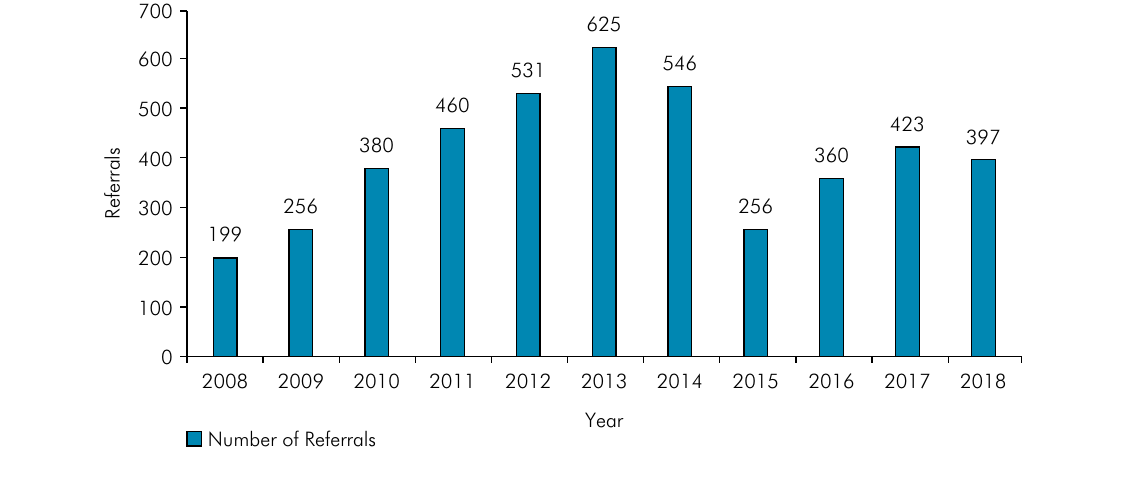
Figure. Distribution of referrals by